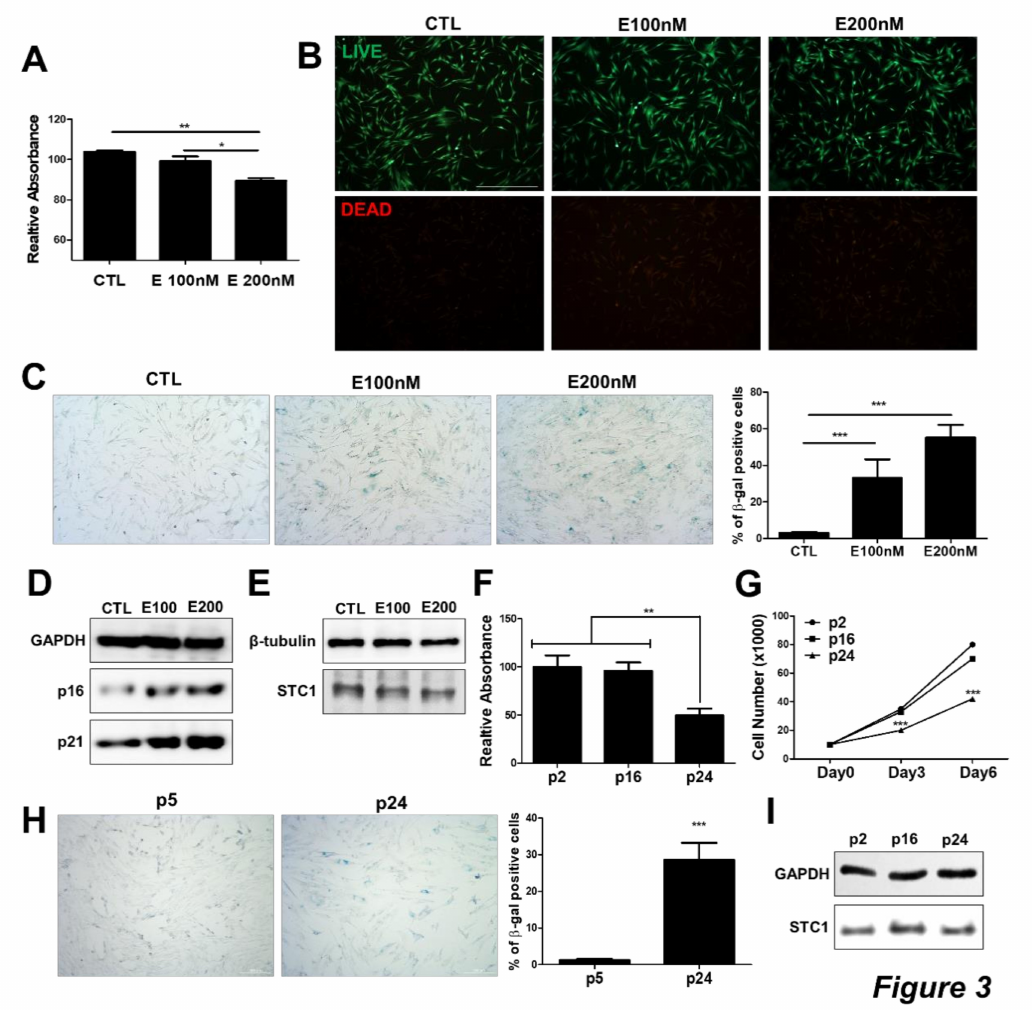
Figure 3. STC1 expression in etoposide-mediated senescent TMSCs. To induce senescence in TMSCs, etoposide was treated to TMSCs for 3 days then cellular senescence, as well as viability, was analyzed. Cell viability was measured by CCK8 assay ( A ) and Live / Dead assay kit ( B ).Cellular senescence was determined by staining for β -galactosidase ( C ). protein levels of cellular senescence markers and STC1 in TMSCs were detected by immunoblotting upon etoposide treatment ( D , E ). Replicative senescence was induced and cell viability and proliferative capacity was analyzed by MTT assay ( F ) and cell counting ( G ), respectively. The distribution of senescent cells was determined by β -galactosidase staining ( H ). STC1 protein levels at passage 2, 16, and 24 were assessed by immunoblotting ( I ). Results are three technical replicates of TMSC from one donor. Representative results from two di ff erent TMSCs with similar tendency were presented. * P < 0.05, ** P < 0.01, *** P < 0.001. Scale bar = 500 µ m) and 200 µ m (H). Results are shown as mean ±